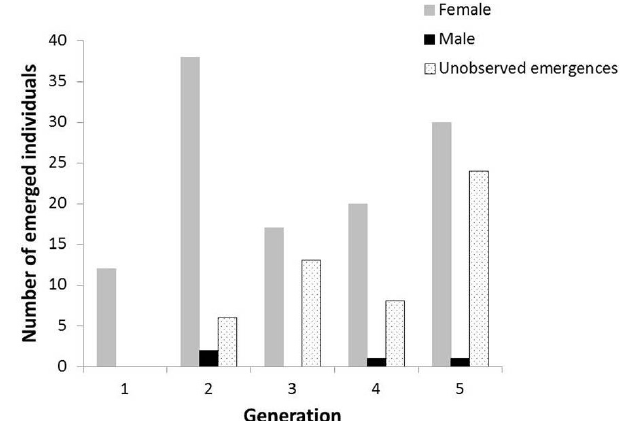
Fig 2. Number of females, males and unobserved emergences during five generations of Euglossa annectans based on the observed number of brood cells Except for those of the first generation, not all emerging bees were observed and sexed. The sex ratio was biased to females even when all non-sexed individuals (dotted bar) were theoretically considered as males (dotted bar + black bar = ♂ vs. grey